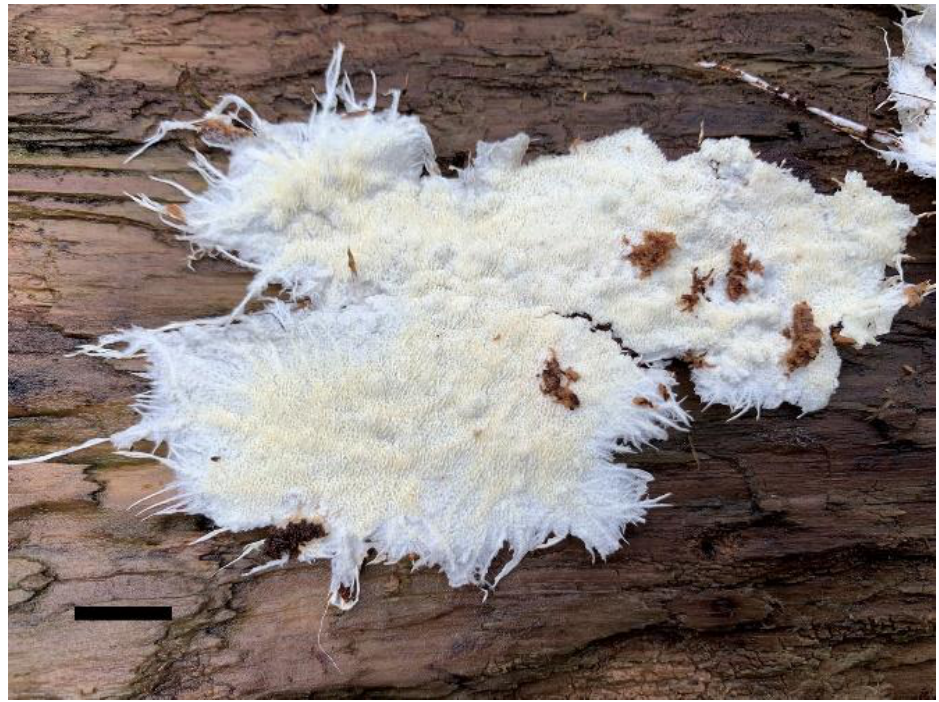
Figure 2. A basidiocarp of Anomoloma denticulatum (Dai 23150). Scale bar = 1.0 cm. MycoBank: